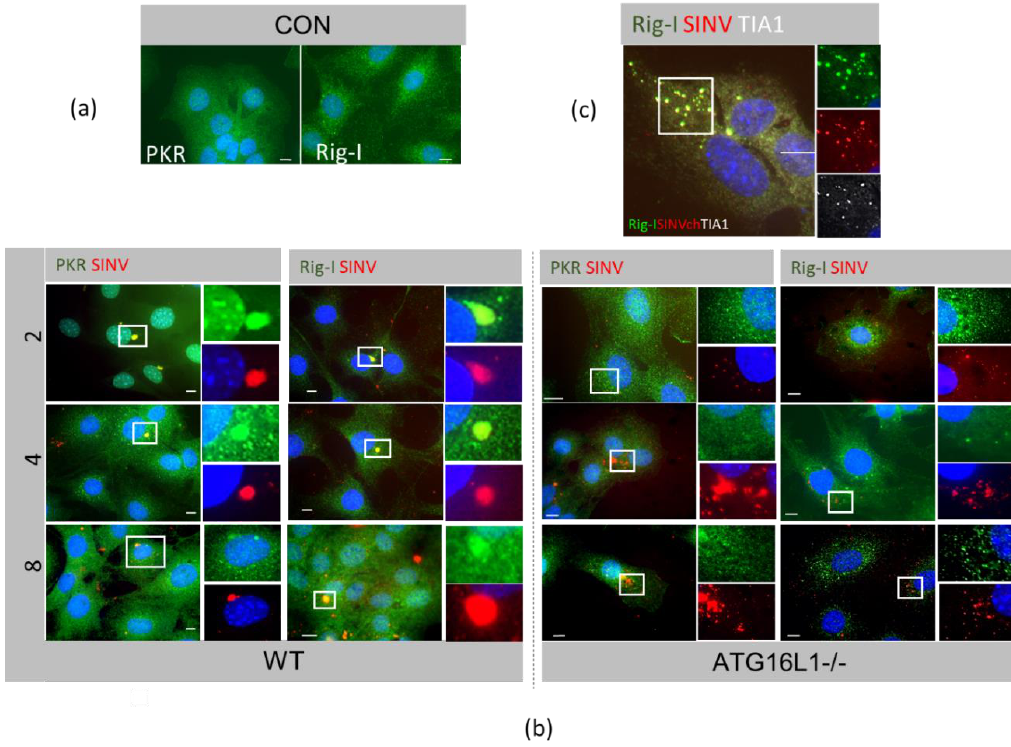
Figure 5. Viral dsRNA sensors PKR and RIG-I redistribute with viral capsid. Cells were immunostained for PKR, RIG-I and TIA-1. ( a ) Control uninfected wild type MEFs (CON) ( b ) Wild type (WT) and ATG16L1- / - cells infected with SINV mCh.capsid for a time course of 2, 4 and 8 hpi. ( c ) ATG16L1- / - infected with SINVmCh.capsid for 8 hpi. Interferon synthesis is required to induce several interferon stimulated genes or ISGs [14]. Type